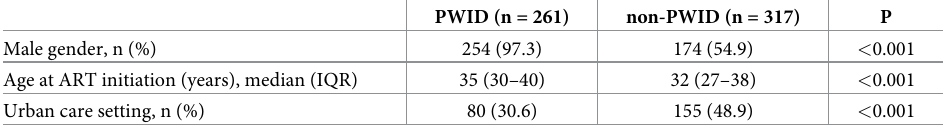
Table 1. Baseline characteristics of PWID and non-PWID. PWID (n = 261) non-PWID (n = 317) P Male gender, n (%) 254 (97.3) 174 (54.9) <